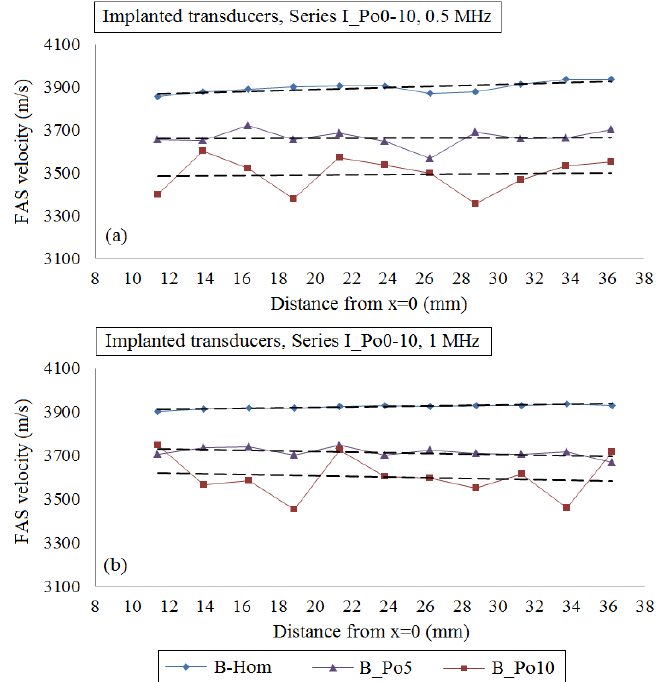
Figure 5. Linear fit derived from multiple receiving positions for cortical porosities from 0 to 10%. The diagrams correspond to the first set of simulations under the assumption of implanted transducers and the excitation frequencies: ( a ) 0.5 MHz; and ( b ) 1 MHz. The corresponding equations, coefficients of determination and root mean square errors are presented in Tables 3 and 4. Table 3. Linear fit of the mean first arriving signal (FAS) velocities derived from all the receiving positions and the excitation frequency 0.5 MHz.